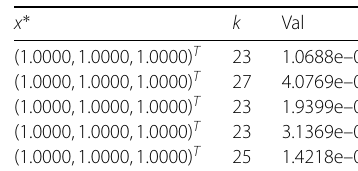
Table 1 Numerical results for Example 4.1